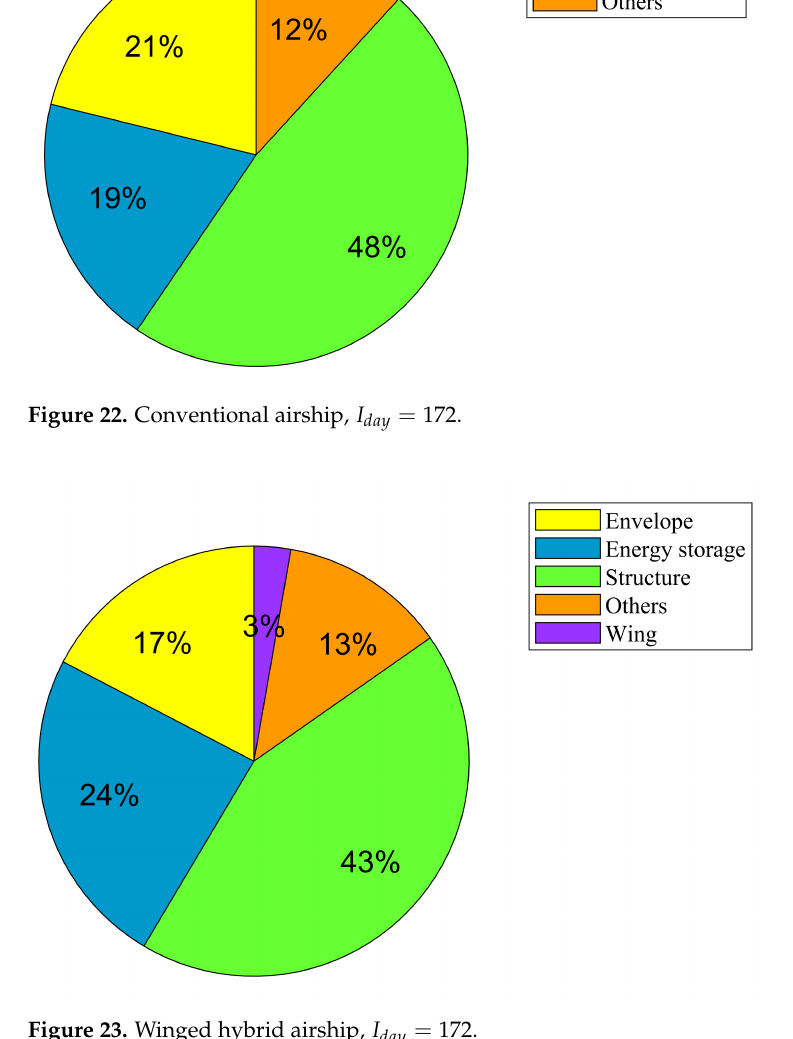
Figure 23. Winged hybrid airship, I day =